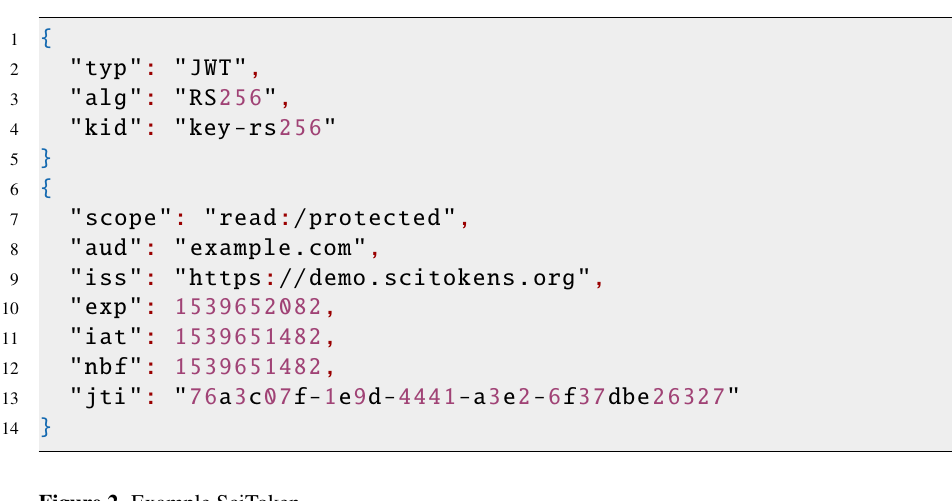
Figure 1. Token flow in a workflow